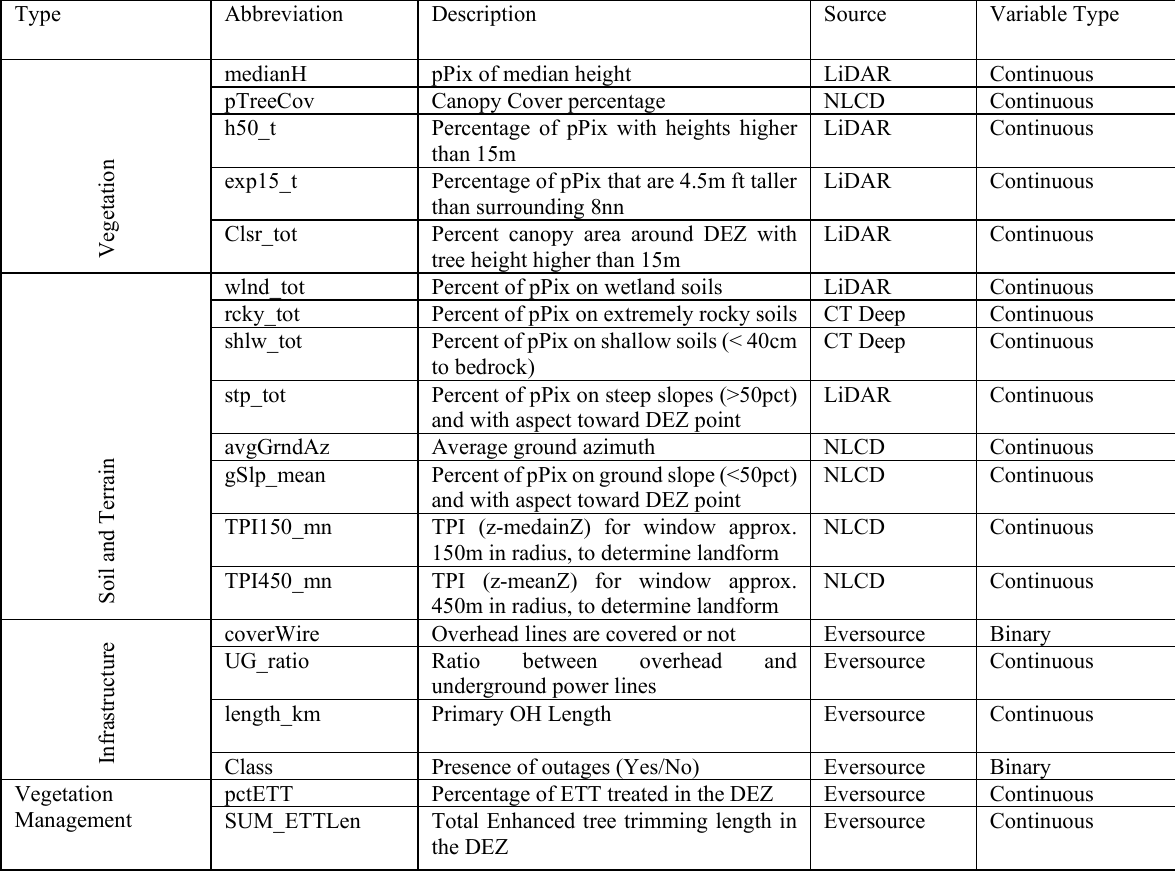
Table 1. List of explanatory and response variables included in the machine learning model development